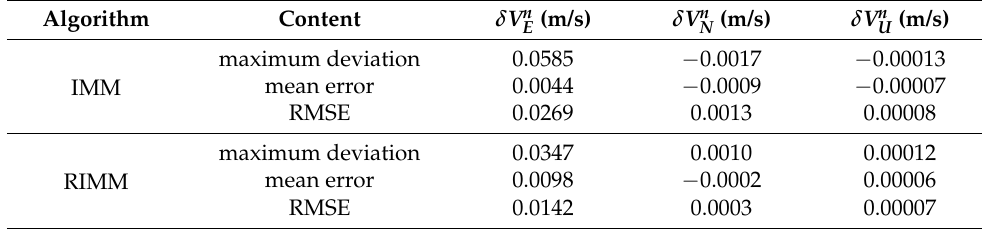
Table 7. Velocity error parameters for the two algorithms.